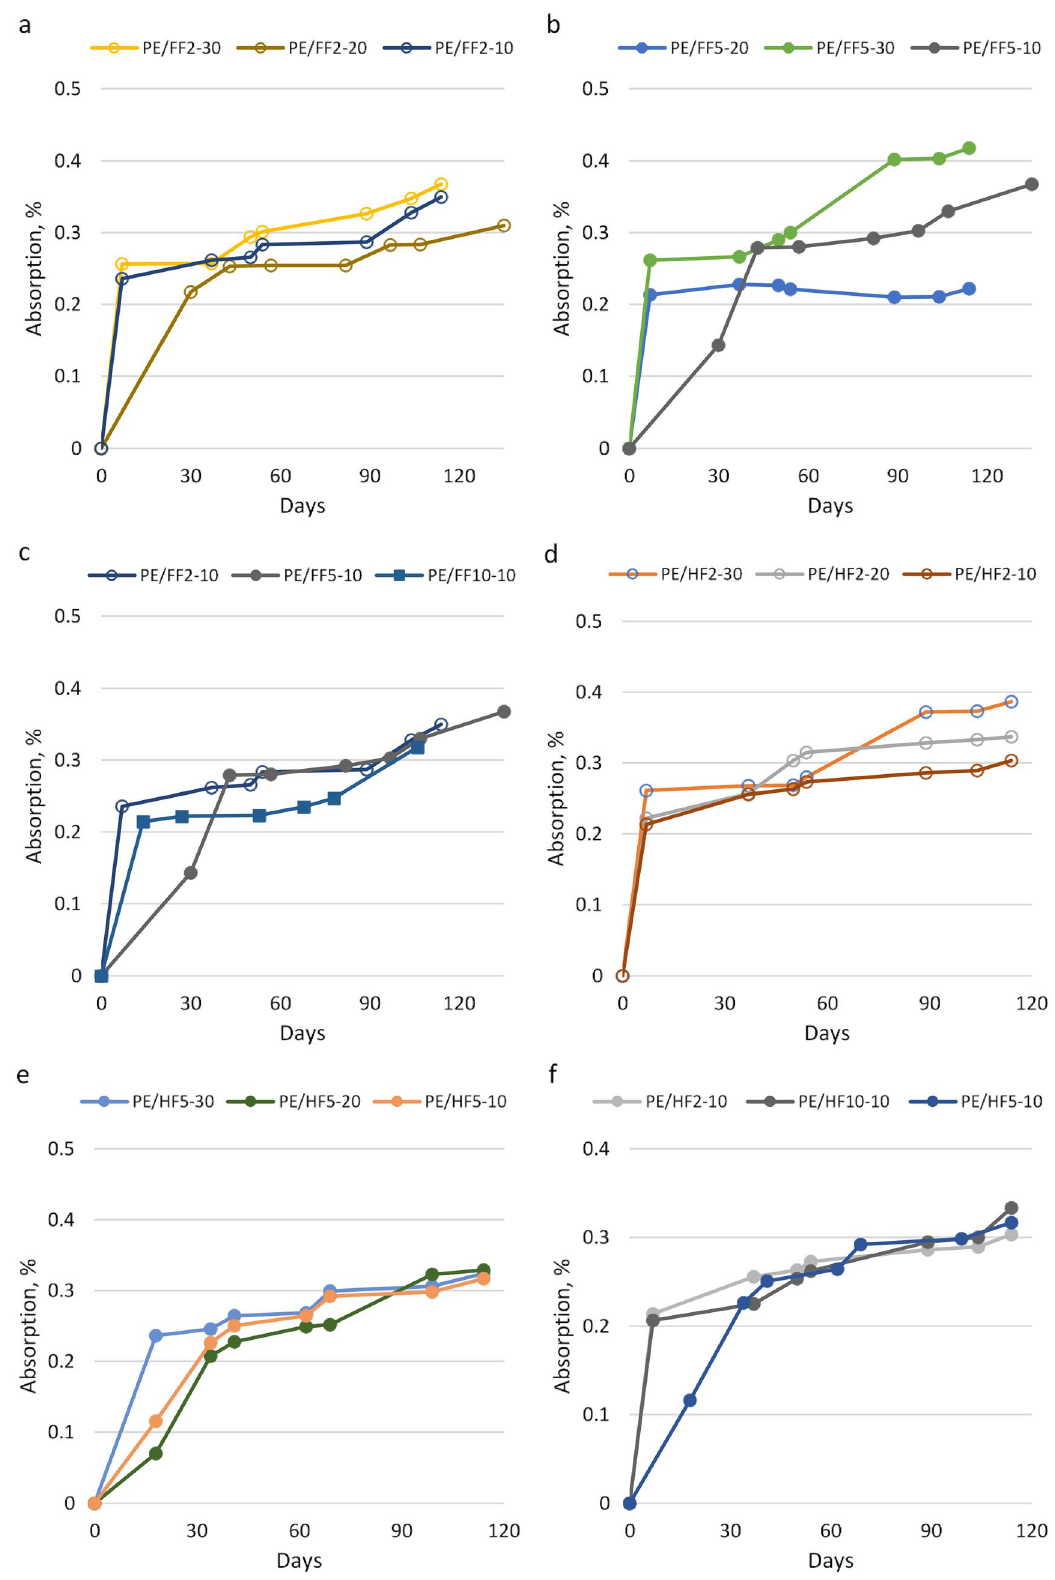
Figure 1. Moisture sorption of bio-composites with flax and hemp fibers at 50% RH; ( a ) flax fiber 2 mm, ( b ) flax fiber 5 mm, ( c ) 10% flax fiber 2 mm, 5 mm, 10 mm, ( d ) hemp fiber 2 mm, ( e ) hemp fiber 5 mm, ( f ) 10% hemp fiber 2 mm, 5 mm,10